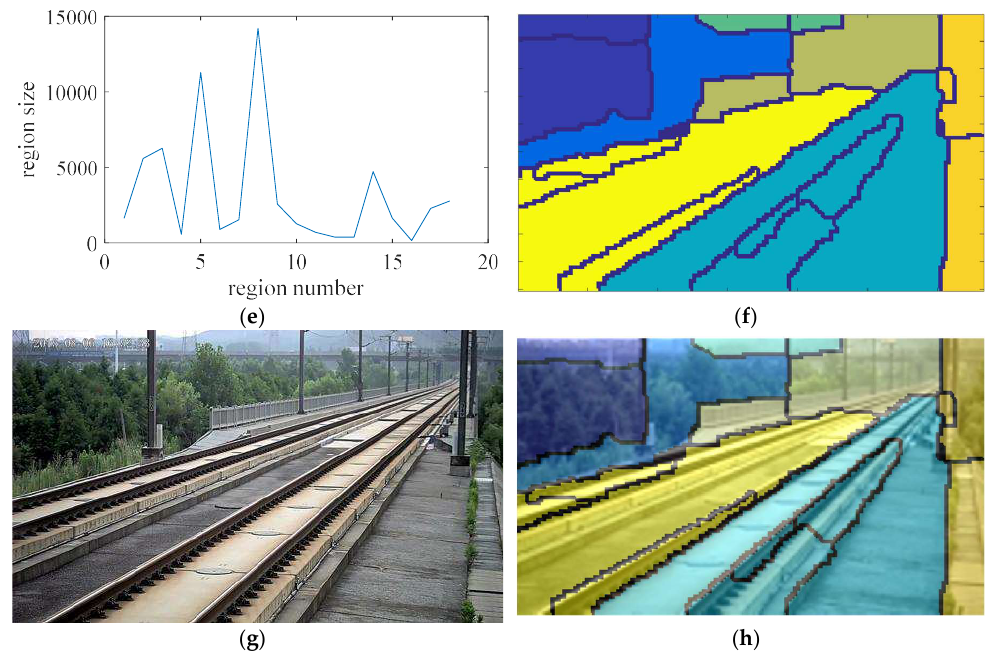
Figure 7. The procedures of combining the fragmented regions into local areas. According to the adjustment and experiments, for the railway scene, the scene image is set to a pixel size of 90 × 150, the number of adaptive θ is reduced to 4, the number of reserved areas Q is set to 10, and the smallest fragmented area S is set to 10% of the total size of the image. ( a ) Boundary with weight. ( b ) Distribution of boundary weight and quantity. ( c ) Delete the weak boundary. ( d ) Fragmented regions. ( e ) Distribution of the region size and serial number. ( f ) Local areas after the fragmented regions are combined. ( g ) The original railway scene image, ( h ) is the result.